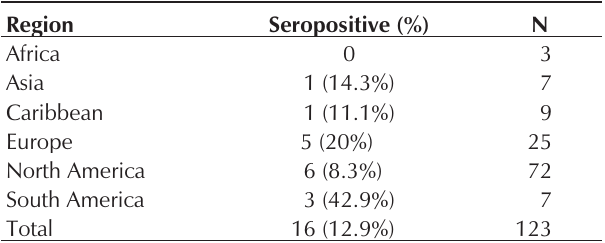
Seroprevalence of toxoplasmosis by region of birth, Toronto Child Care Study,